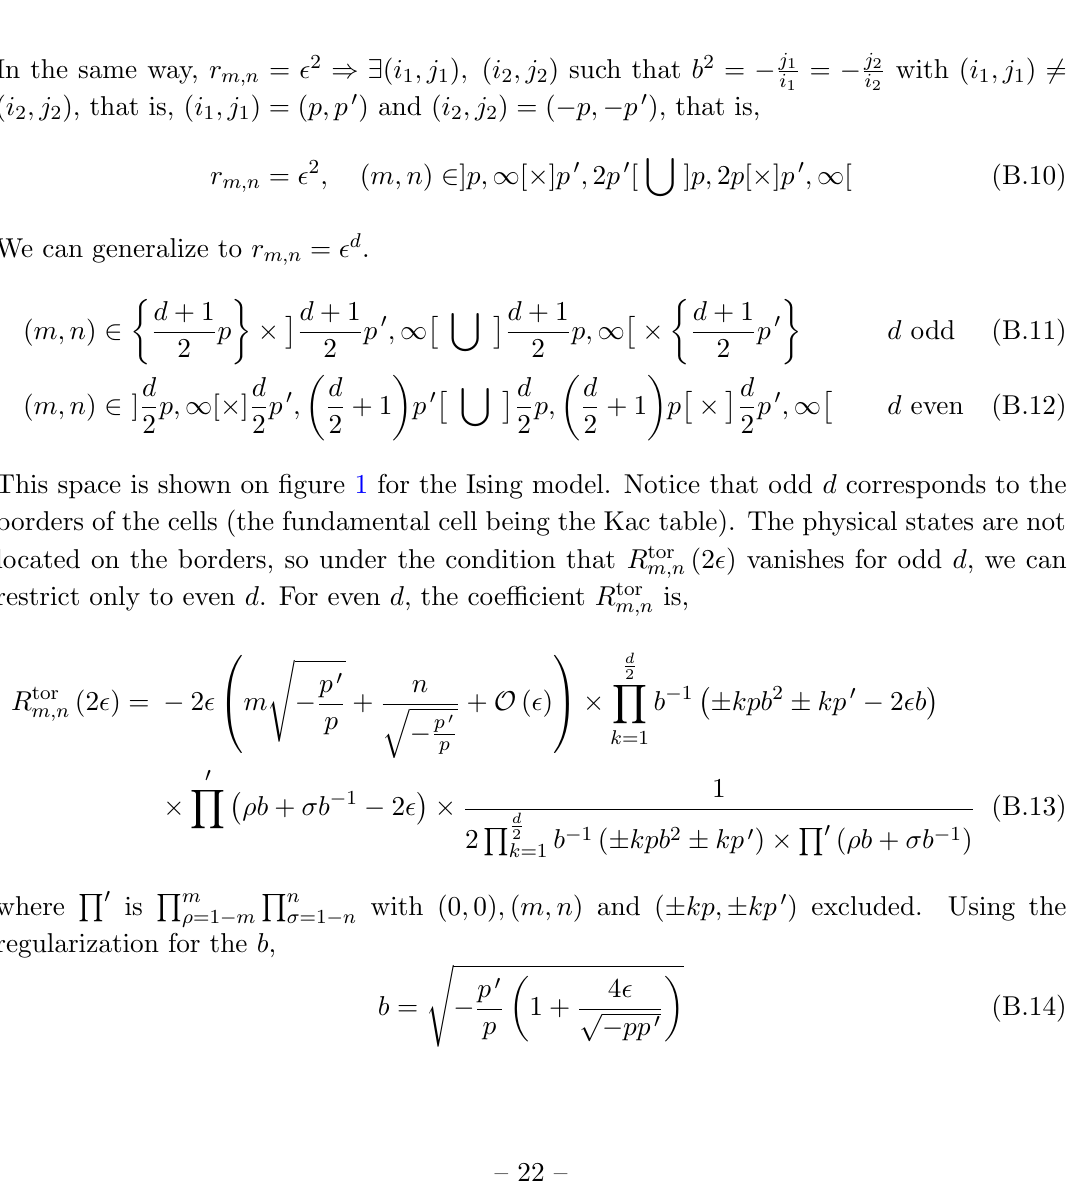
Figure 1 . Degree d for the Ising model p = 4, p 0 = 3. Green dots are the values for which D m;n 6 =